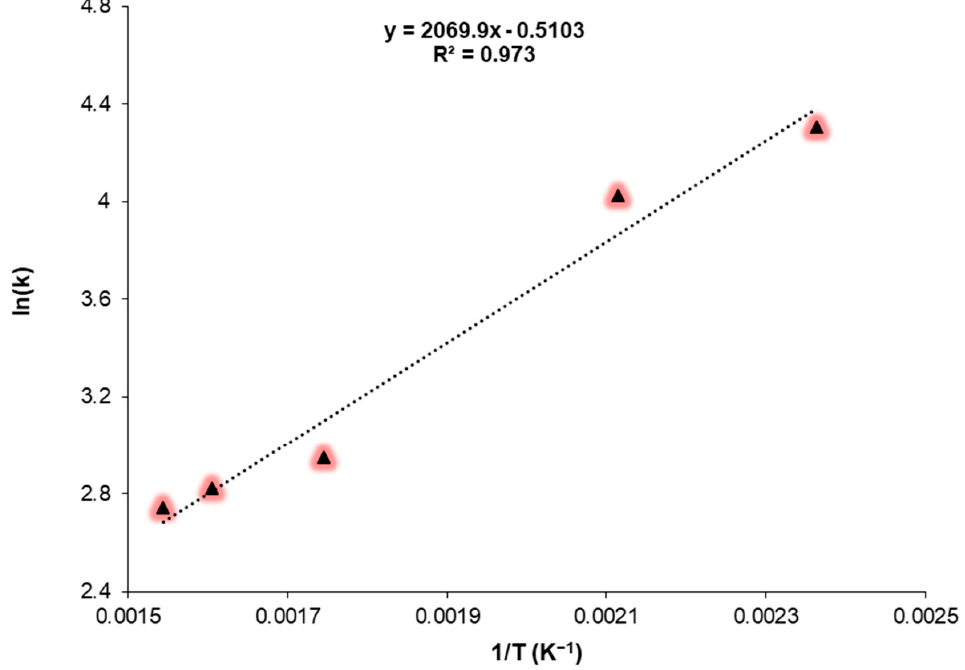
Figure 9. Arrhenius plot for IPA synthesis over CAT-IV.